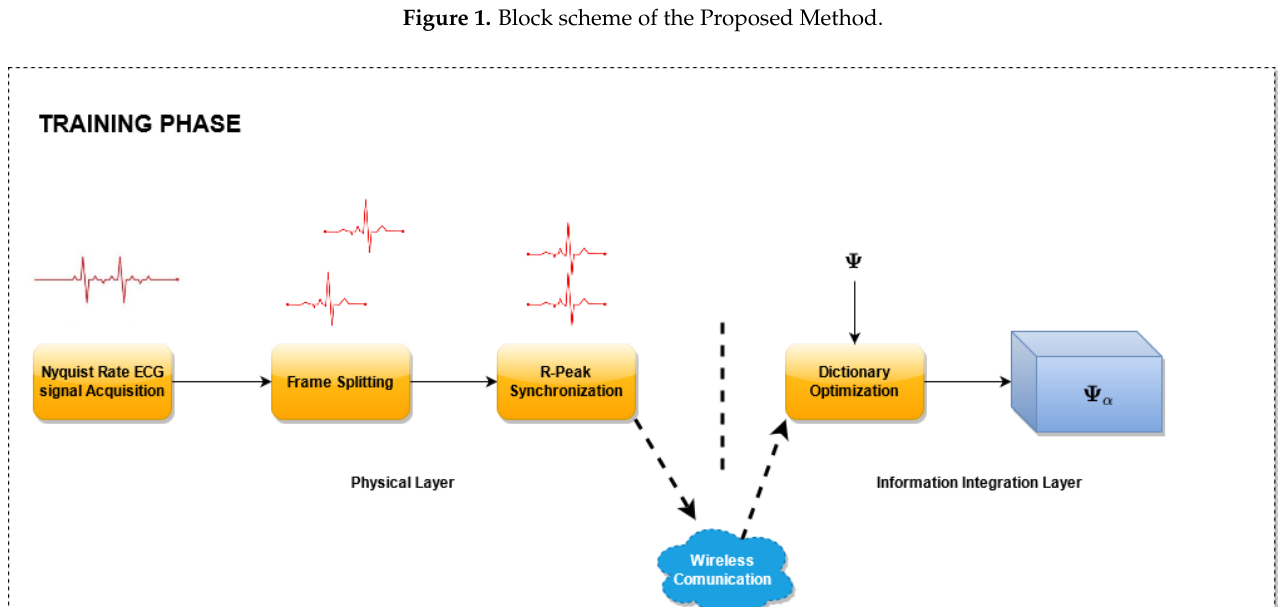
Figure 2. Block scheme of the training